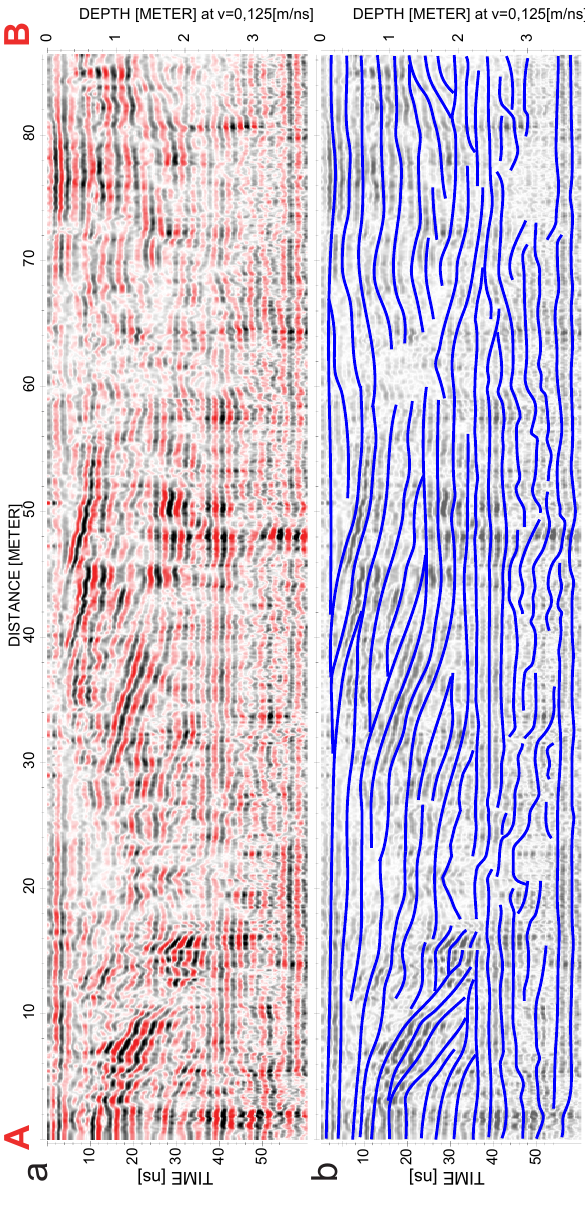
Figure 13. SW–NE profile crossing the central Cyclone Canyon. (a) 400MHz profile without interpretation. (b) Profile with inter- pretation (blue lines: interpreted layers). This profile shows no faults but sedimentary structures such as foreset